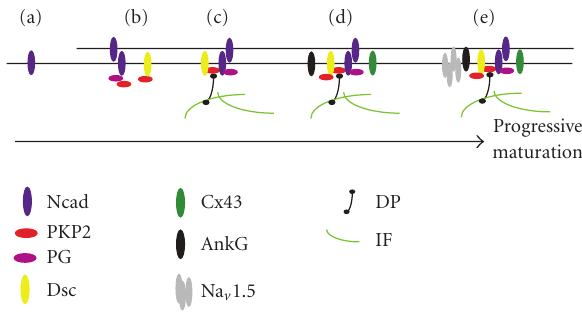
Figure 10: Progressive maturation of the intercalated disk (a)– (e). (a) As cardiomyocytes remodel, N-cadherin (Ncad) distributes di ff usely around the cell periphery. (b) When cells contact adjoining cells, desmocollin (Dsc) proteins of the armadillo family including plakoglobin (PG) and plakophillin-2 (PKP2) co-localize with N-cadherin at the cell contact site. (c) The nascent adhesive contacts recruit desmoplakin (DP) and the associated intermediate filaments. (d) After assembly of the adhesive plaque, connexin- 43 (Cx43) and ankyrin-G (AnkG), a component of the VGSC, selectively localize to the adhesive contact site. (e) The α subunit of the voltage-gated sodium channel Na is incorporated significantly later into the more mature intercalated disks where they associate with ankyrin-G. The assembly process begins with the clustering of transmembrane adhesive contacts, followed by the recruitment of the plaque proteins and reorganization of the subcortical cytoskeleton. The process culminates with the recruitment of gap junctions and components of the VGSC complex (AnkG and Na v 1.5) which are also assembled in a step-wise